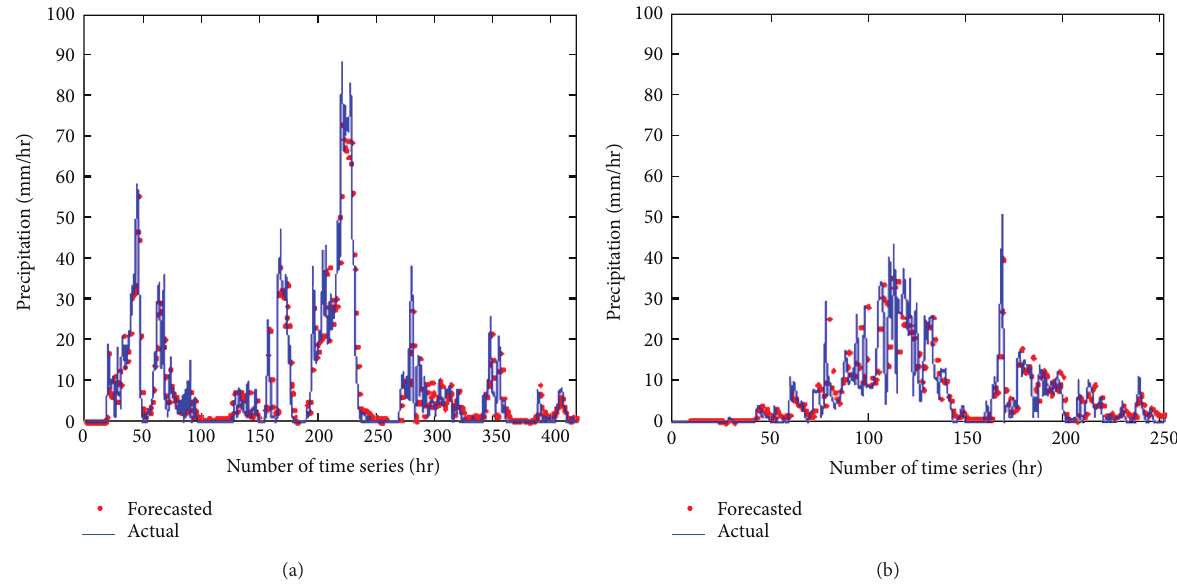
Figure 16: The validation and testing precipitation forecast results at 𝑡 + 1 of the ANFIS-based hybrid dual-model at Yu-Feng station: (a) validation; (b) testing.